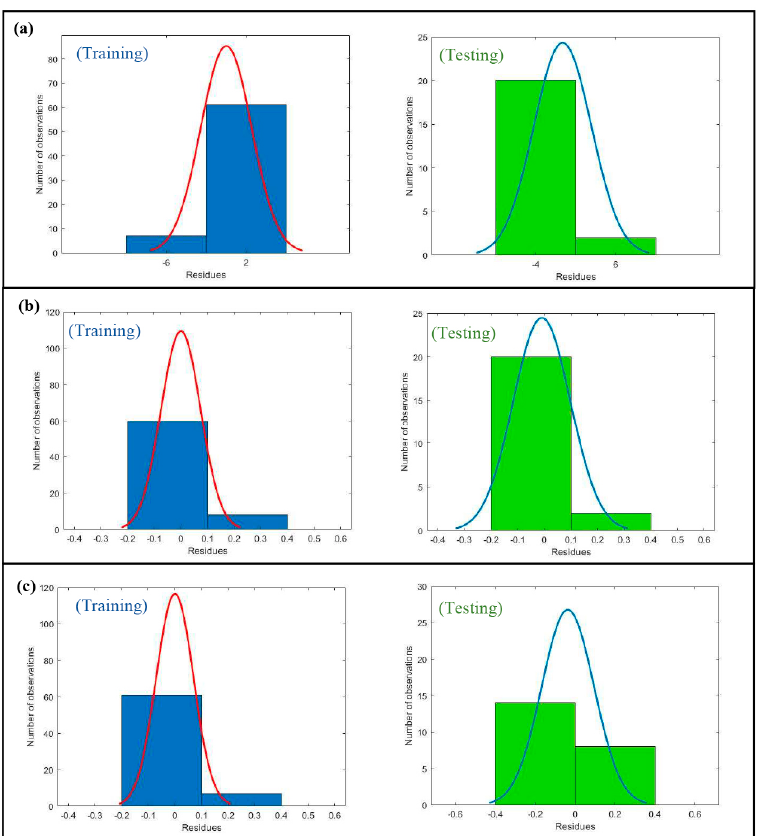
Figure 2. Histogram of residuals in training sets and testing sets of ( a ) rooting percentage, ( b ) root number, and ( c ) root length in P. caerulea .